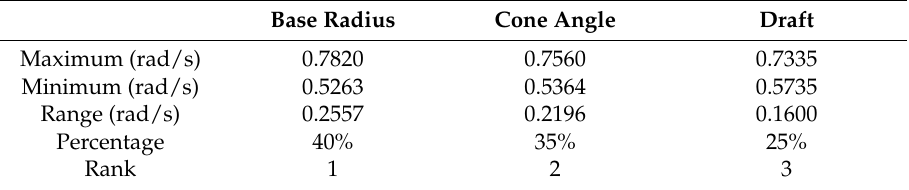
Table 6. Influence degree of geometric parameters on resonance